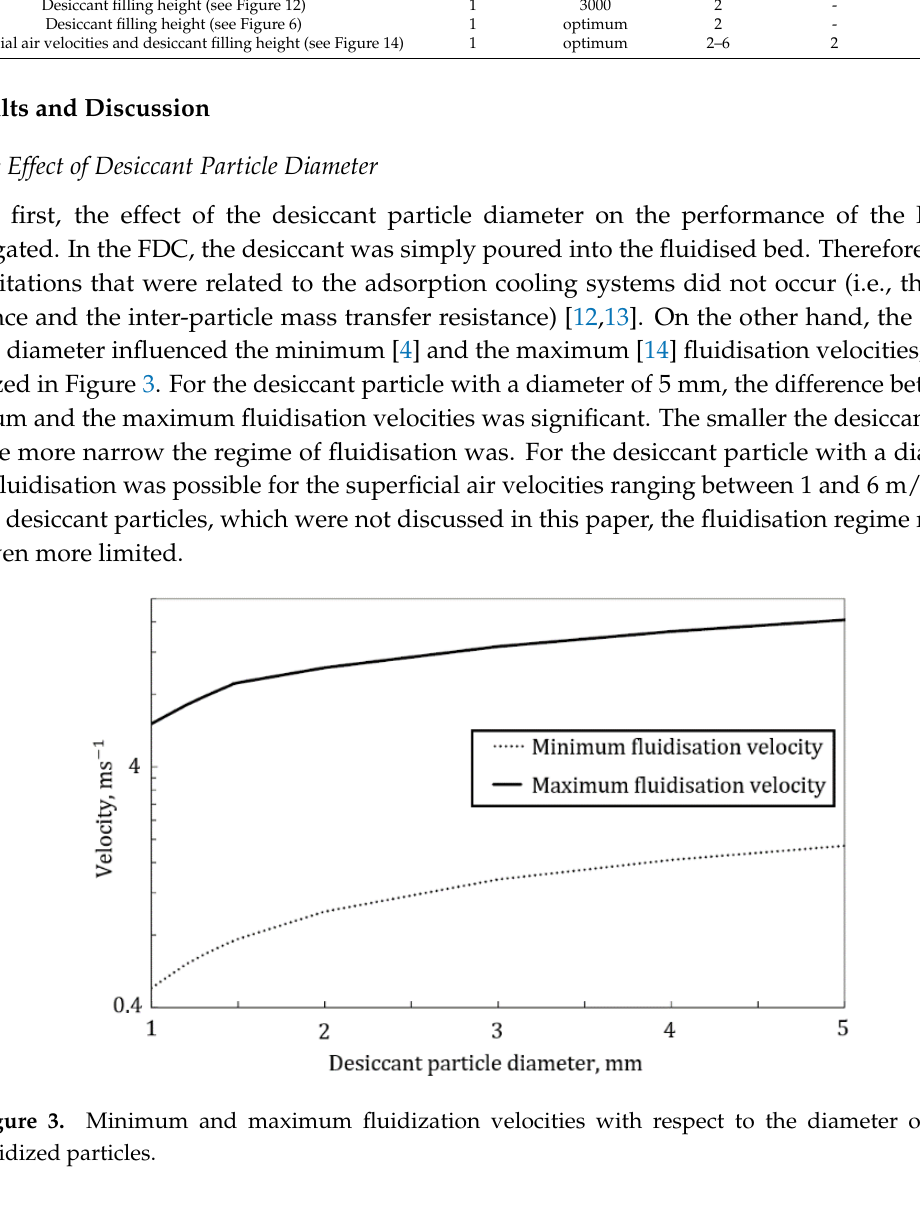
Table 1. Operating parameters used in analyzes.